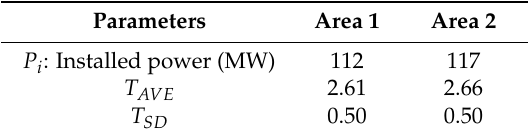
Table 1. The variation range of the